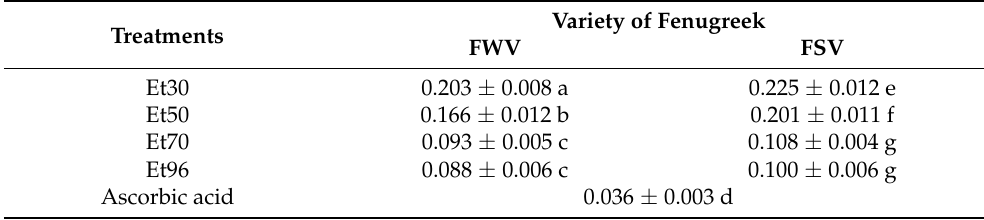
Values shown are means ± standard error. Values within columns and between the extracts of the two varieties bearing the same letter are not significantly different ( p < 0.05). Treatments: Et30 = extract with 30% ethanol; Et50 = extract with 50% ethanol; Et70 = extract with 70% ethanol; Et96 = extract with 96% ethanol.